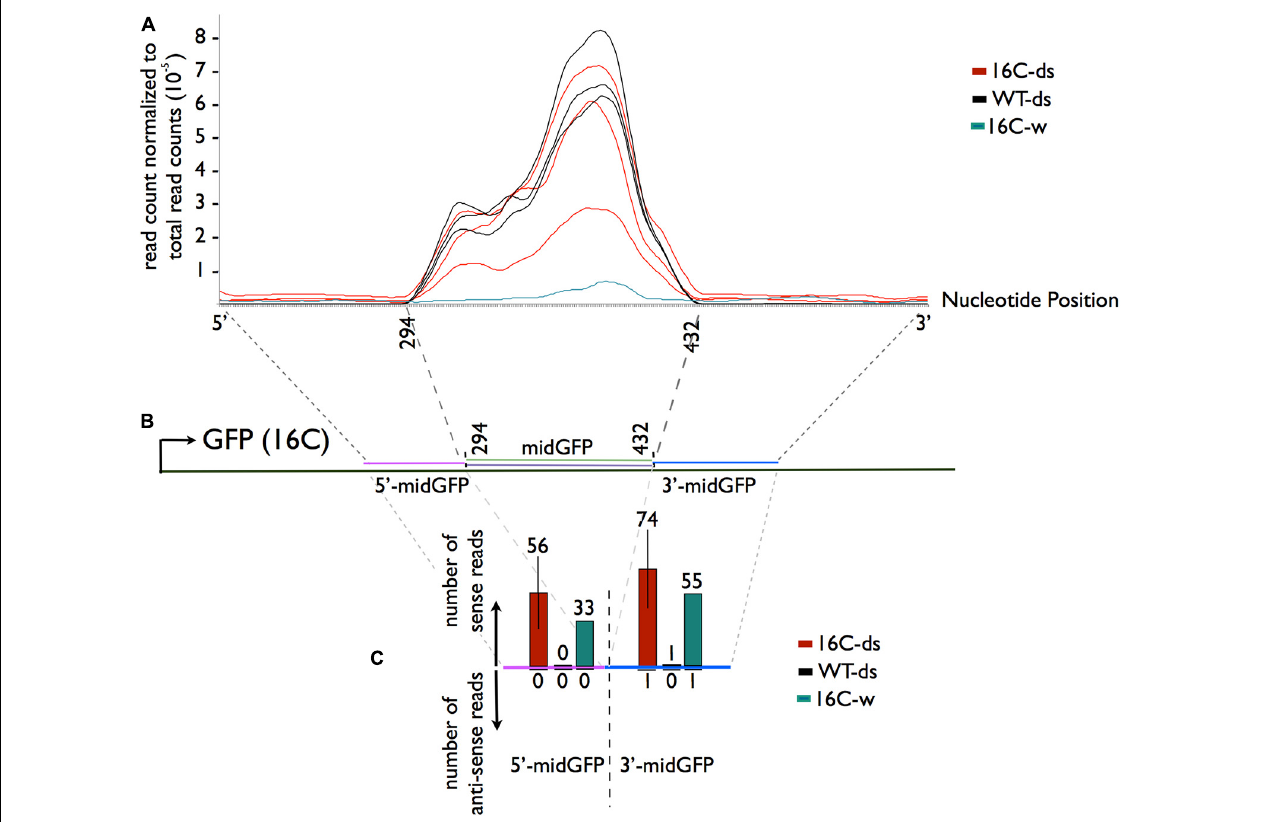
FIGURE 3 | Sequence specific distribution of sRNAs. (A,B) SRNA reads mapping to the midGFP region and to the 5 (cid:48) (magenta) and 3 (cid:48) (blue) regions flanking the midGFP sequence regardless of the direction were normalized to the total read counts. There is no enrichment of 16C-ds reads over the WT-ds reads in the midGFP region, suggesting that there is no further amplification of the sRNAs in the presence of GFP transcript in 16C-ds. (C) The average raw read counts in the neighboring regions were shown to analyze transitivity. There are no anti-sense reads accumulating in 16c-ds samples outside of the sprayed area (downward arrow). The reads matching to the sense strand are degradation products of the GFP transcript, as they can be observed in 16-w sample but not WT-ds samples (upward